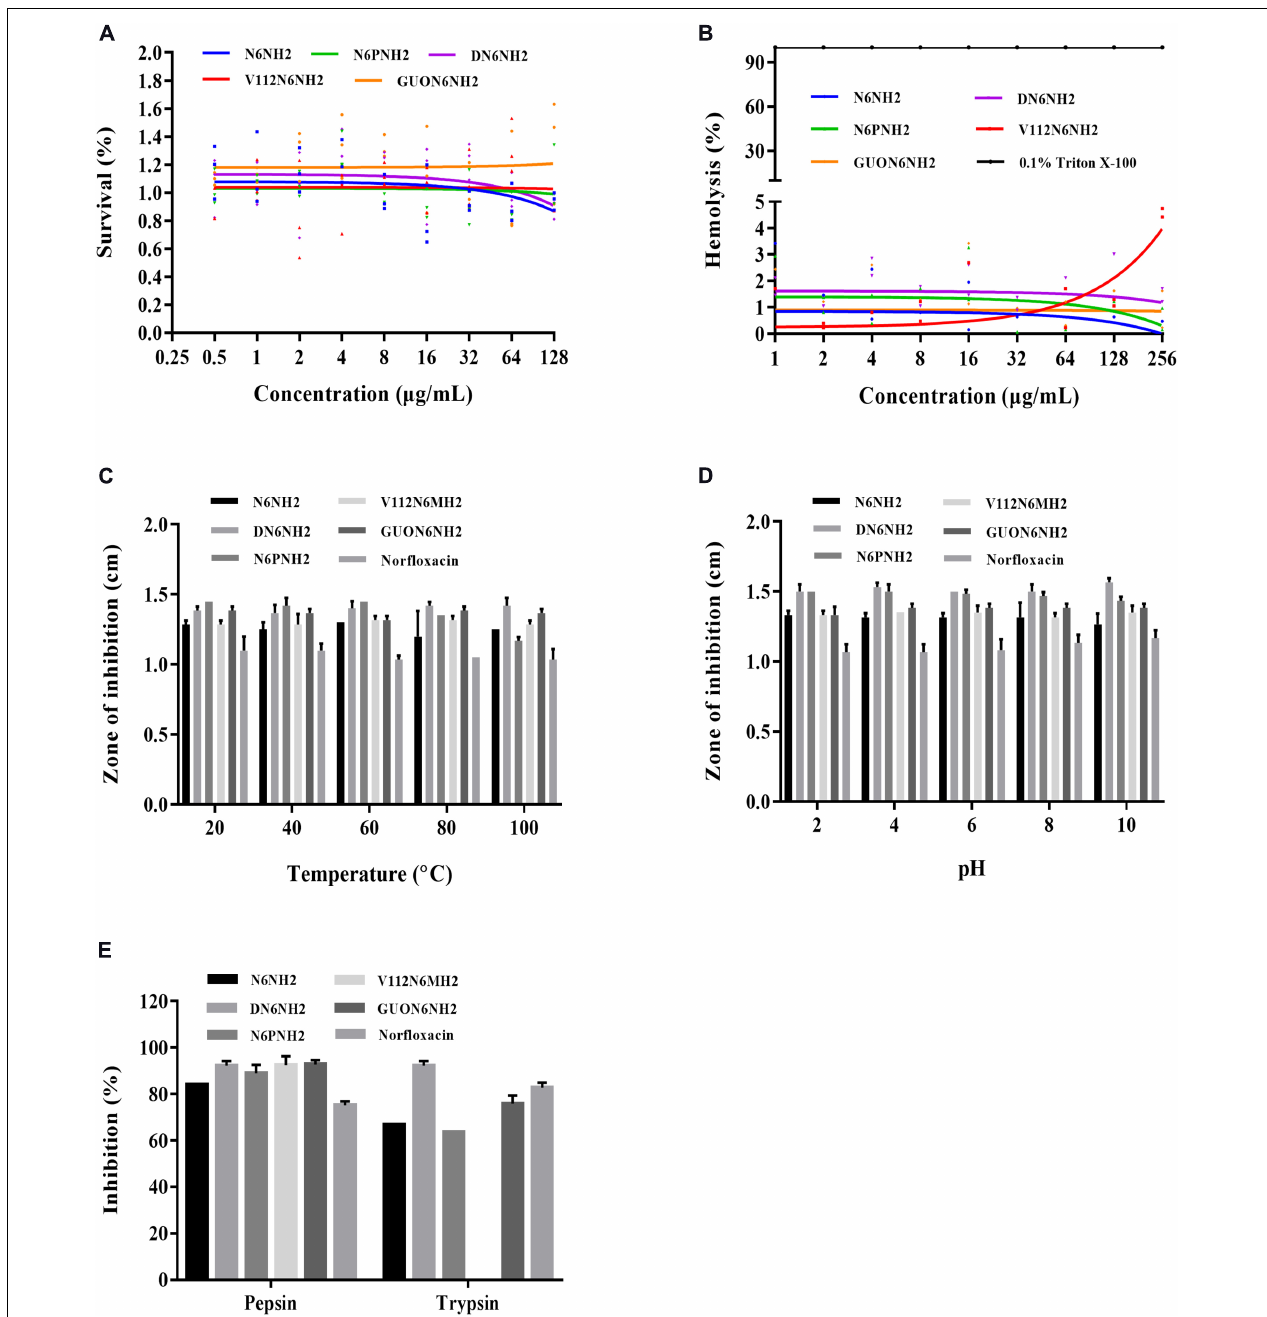
FIGURE 1 | Hemolysis, cytotoxicity, and stability of N6NH2 and its derivatives. (A) Cytotoxicity of the peptides against RAW 264.7 cells. N6PNH2, V112N6NH2, and GUON6NH2 showed lower cytotoxicity than N6NH2 and DN6NH2. (B) Hemolytic activity of the peptides against murine erythrocytes. Derivatives of N6NH2 have very low or no hemolytic activity. (C–E) The effects of temperature (C) , pH (D) , and proteases (E) on the antibacterial activity of the peptides in vitro against E. tarda . The results are given as the mean ± SEM ( n = 3). All peptides showed high stability toward temperature and pH. GUON6NH2 was more resistant to trypsin than N6NH2 and V112N6NH2, inferior to